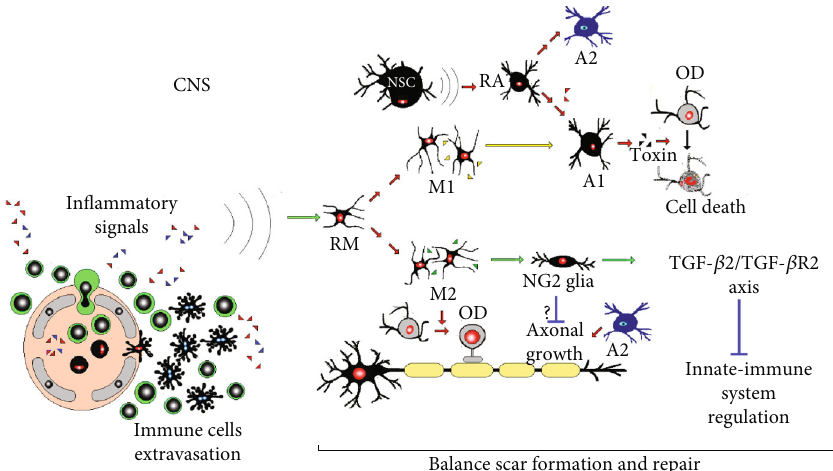
Figure 5: Complexity of brain cell interactions in scar formation and